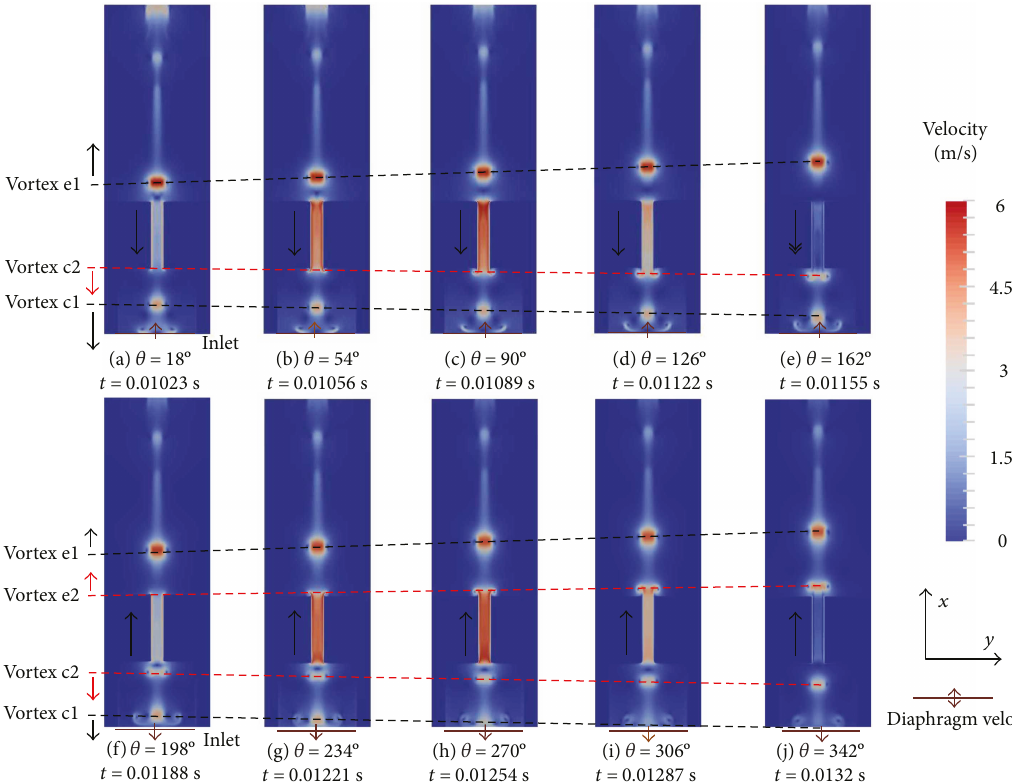
Figure 9: Velocity contour in the 4th cycle at cross section A with sinusoidal diaphragm velocity condition.